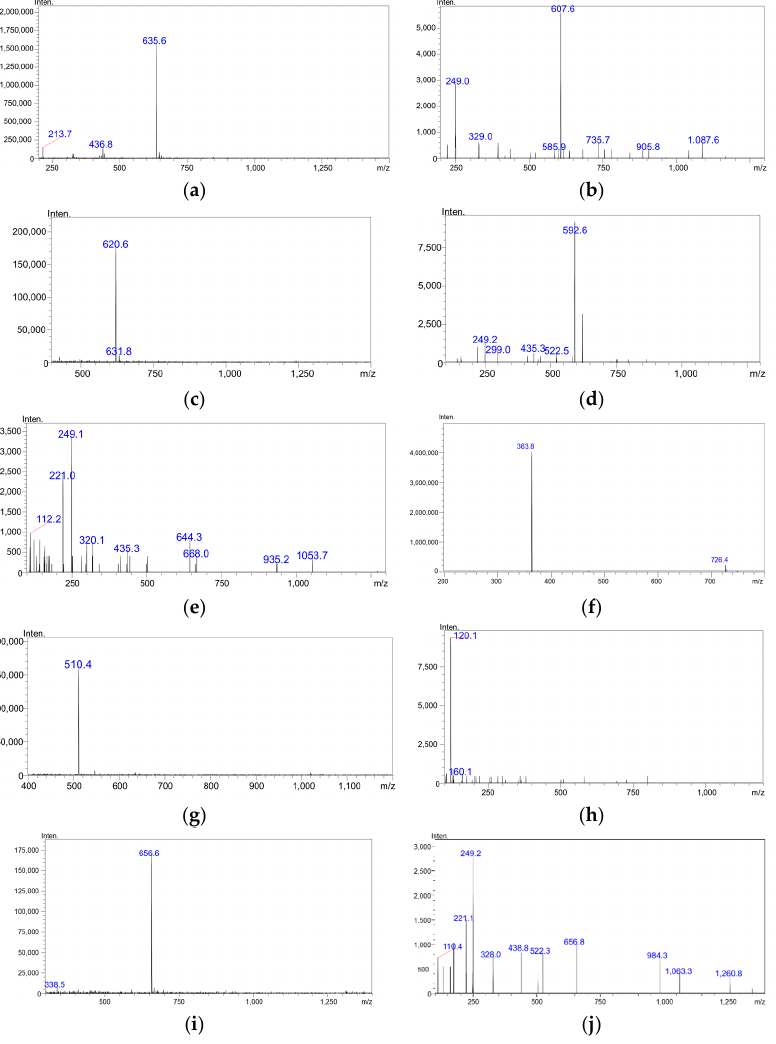
Figure 3. Current mass spectrum produced by LC-ESI-MS/MS for ( a ) goserelin total ion; ( b ) goserelin product ion m / z 635.60, positive ESI, collision energy − 20 V; ( c ) buserelin total ion; ( d ) buserelin product ion m / z 592.60 mass spectra, positive ESI, collision energy − 19 V, ( e ) buserelin product ion m / z 241.10 mass spectra, positive ESI, collision energy − 37 V, ( f ) dalargin total ion; ( g ) octreotide total ion; ( h ) octreotide product ion m / z 120.10 mass spectra, positive ESI, collision energy − 34 V; ( i ) triptorelin total ion; ( j ) triptorelin product ion m / z 249.20 mass spectra, positive ESI, collision energy − 40 V. Detection was performed with triple quadruple tandem mass spectrometry in the positive ion mode (5 kW) using the MRM mode. Nitrogen was used as a nebulizer (3 L/h) and drying (20 L/h) gas. The desolvation temperature was set at 200 ◦ C, and the source temperature was 400 ◦ C. Detection conditions are summarized in Table